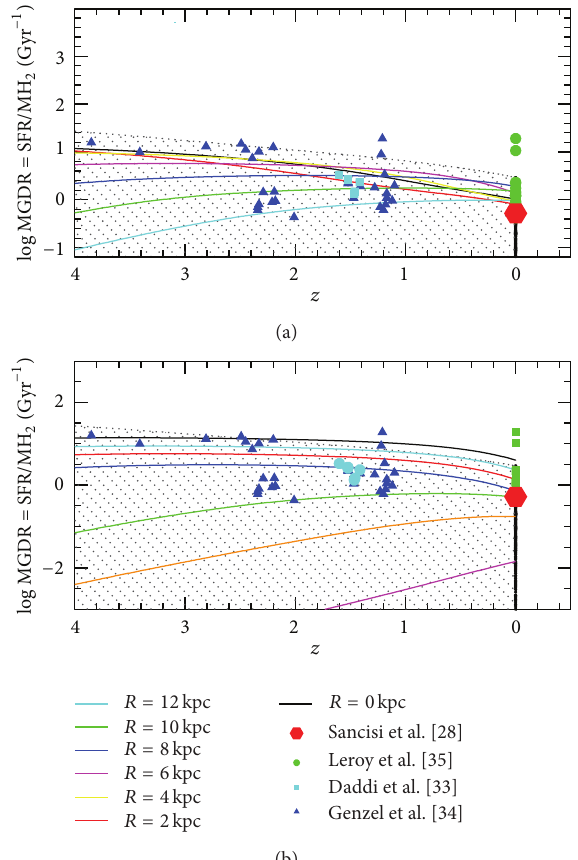
Figure4:Theefficiencytoformstarsfrommoleculargas,SFR /𝑀 in logarithmic scale, as a function of redshift 𝑧 for our grid of models.Theevolutionwithredshiftforallradialregionsandgalaxies is shown by the shaded zone, while solid black points represent the grid results for 𝑧 = 0 . (a) Solid black, red, yellow, magenta, blue, green, and cyan lines, correspond to radial regions located at 0, 2, 4, 6, 8, 10, and 12 kpc of the Galactic center in the MWG model.In(b)solidblack,cyan,blue,red,green,orange,andmagenta lines correspond to galaxies of different dynamical masses and efficiencies (see Table 1). In (a) and (b) observations at intermediate- high redshift from Daddi et al. [99] and Genzel et al. [100] are shown as cyan dots and blue triangles, respectively, while the green squares refers to the local Universe data obtained by Leroy et al. [101]. The red star marks the average given by Sancisi et al.